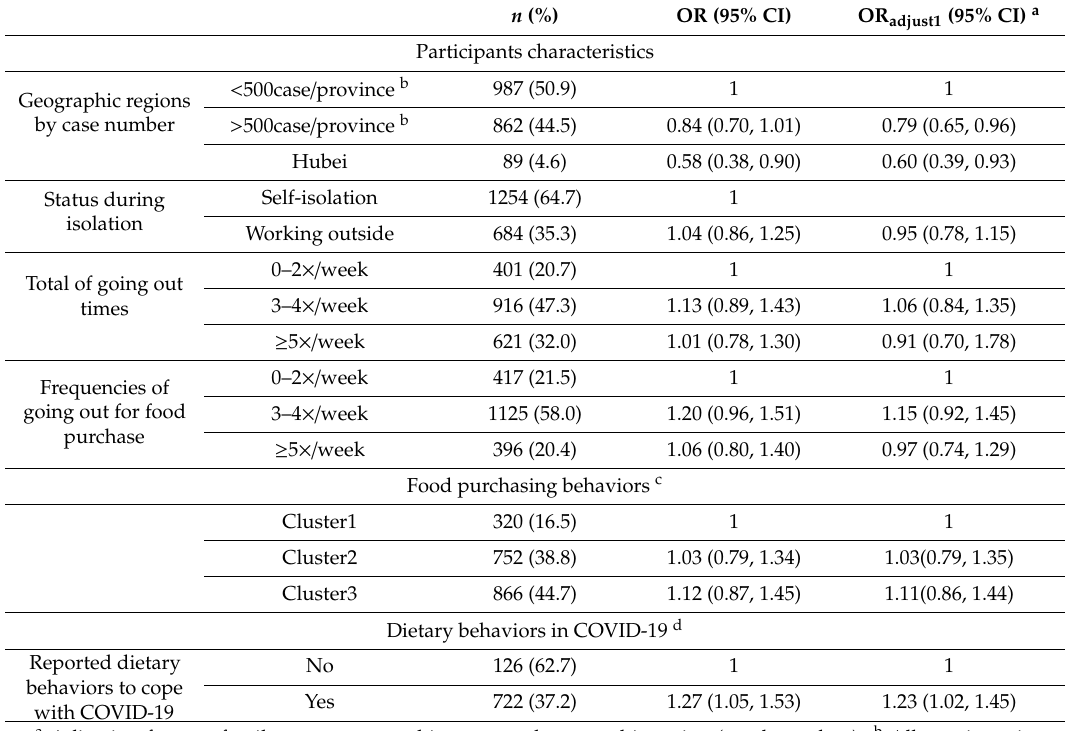
Table 3. Odds of high HDDS comparing participants di ff er in geographic regions, approaches to obtain and purchase foods, frequency of outdoor activity, and dietary behaviors to cope with COVID-19. n (%) OR (95% CI) OR adjust1 (95% CI)